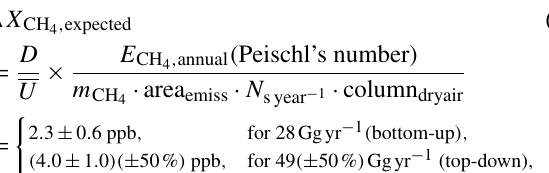
and E CH 4 , annual 4 4 , annual and their uncertainties, as derived in Eq. 14, are 4